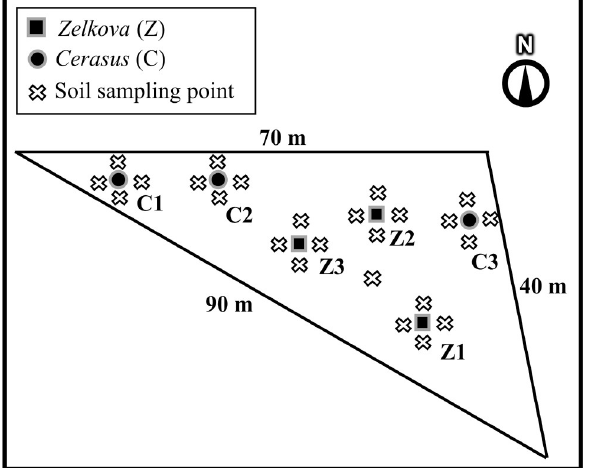
Fig 1. Sampling situation at the perimeter boundary site of the